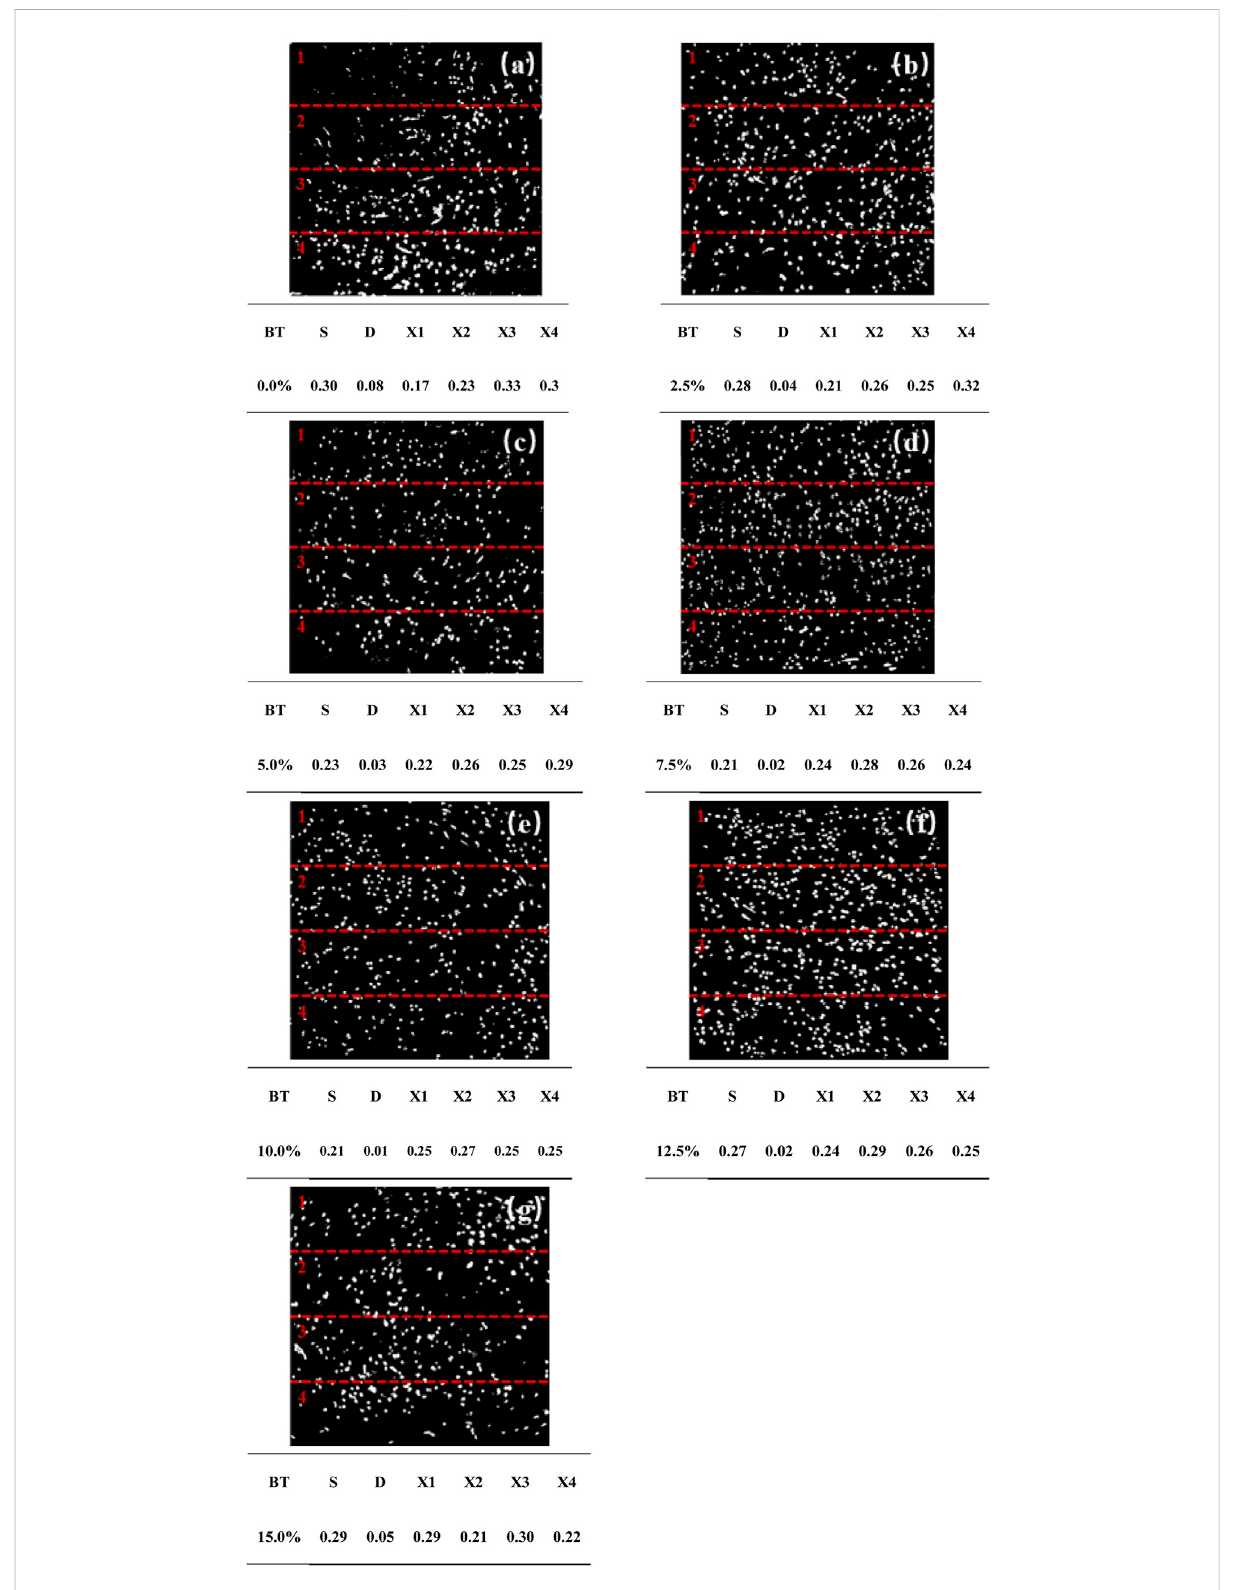
FIGURE 10 Binary images of steel fi bres of the UHPC with different content of bentonite (A) 0%, (B) 2.5%, (C) 5%, (D) 7.5%, (E) 10%, (F) 12.5%, (G) 15%.